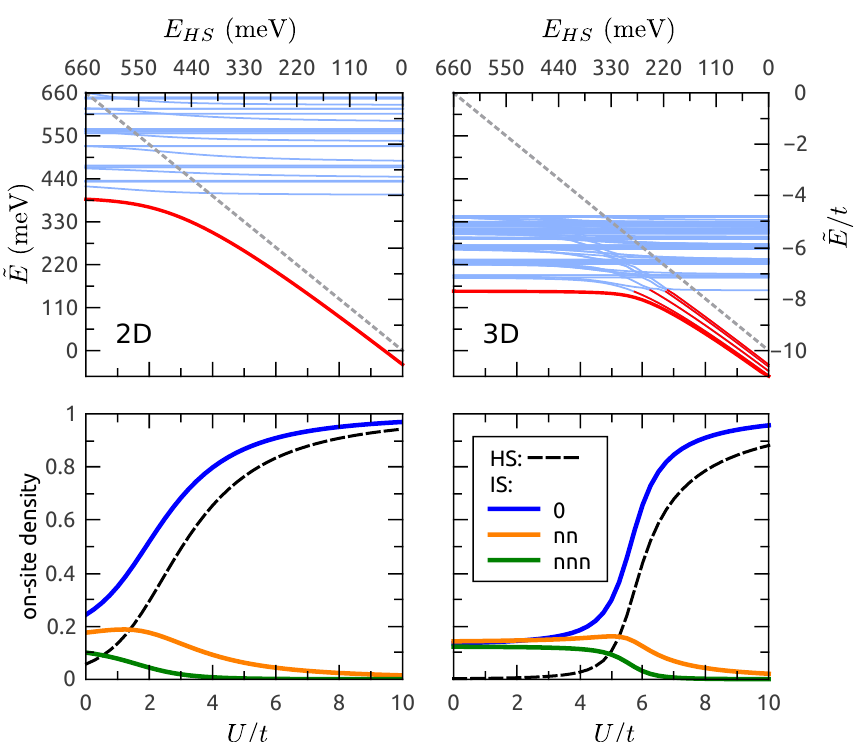
Figure 3: Top row: Energies of the lowest eigenstates in the subspace with one HS state as a function of the IS-IS attraction U . Dashed line marks the bare energy E = 330 meV. The calculations were performed in the geometry described assuming E IS in the text with the linear size L = 8. Bottom row: The IS ground state as a function of U / t . Site 0 is the crossing point (the HS site). The densities on the nn and next-nearest-neighbour (nnn) sites are calculated along the x ( y ) axis. In the 3D case, the density values integrated over the z direction are